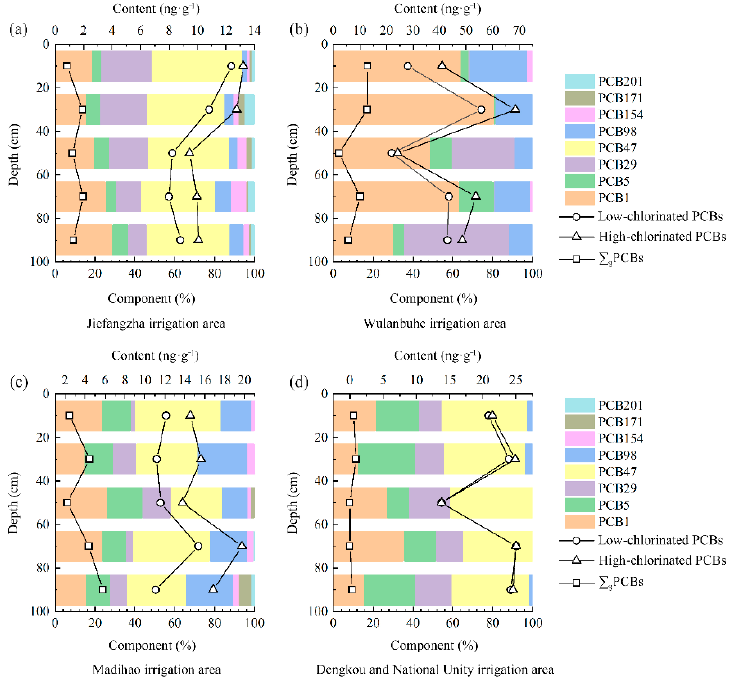
Figure 3. Concentration and component distribution of PCBs in soil profiles of different irrigation